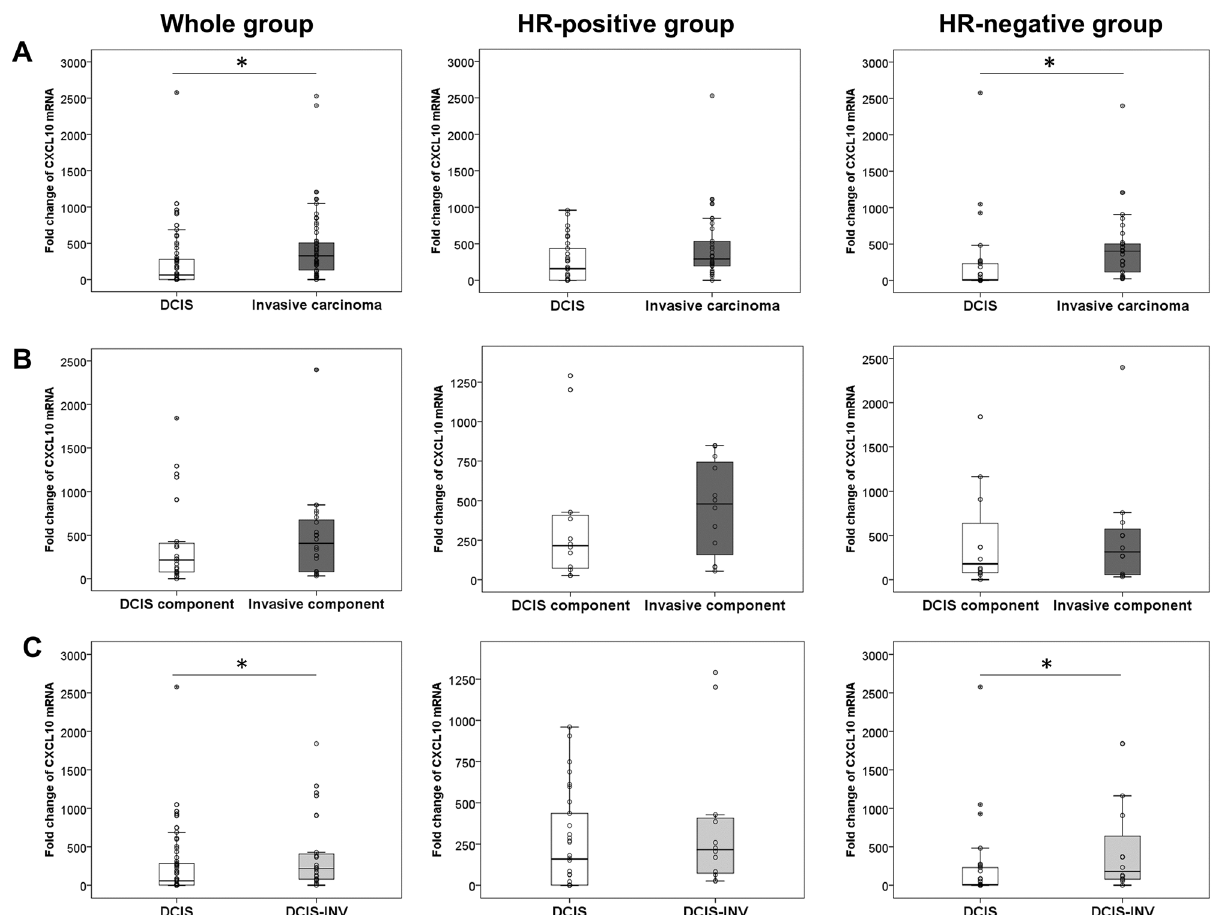
Figure 1. Comparison of CXCL10 mRNA expression between DCIS and invasive carcinoma. ( A ) CXCL10 mRNA expression is significantly higher in invasive carcinoma than in DCIS, in the whole group (n = 120; p < 0.001) and in the hormone receptor (HR)-negative group (n = 60; p < 0.001). ( B ) However, within individual tumors, CXCL10 mRNA expression is not significantly different between DCIS and invasive components of the same tumor in all groups (n = 24, whole group; n = 12, HR-positive and H-negative group). ( C ) In comparison of DCIS (n = 60) with DCIS associated with invasive carcinoma (DCIS-INV) (n = 24), CXCL10 mRNA expression is significantly higher in DCIS-INV than in DCIS in the whole group (n = 84; p = 0.011) and in HR-negative group (n = 42; p = 0.020). *Statistically significant. The graphs were generated using SPSS version 25.0 for Windows (IBM Corp., Armonk, NY,